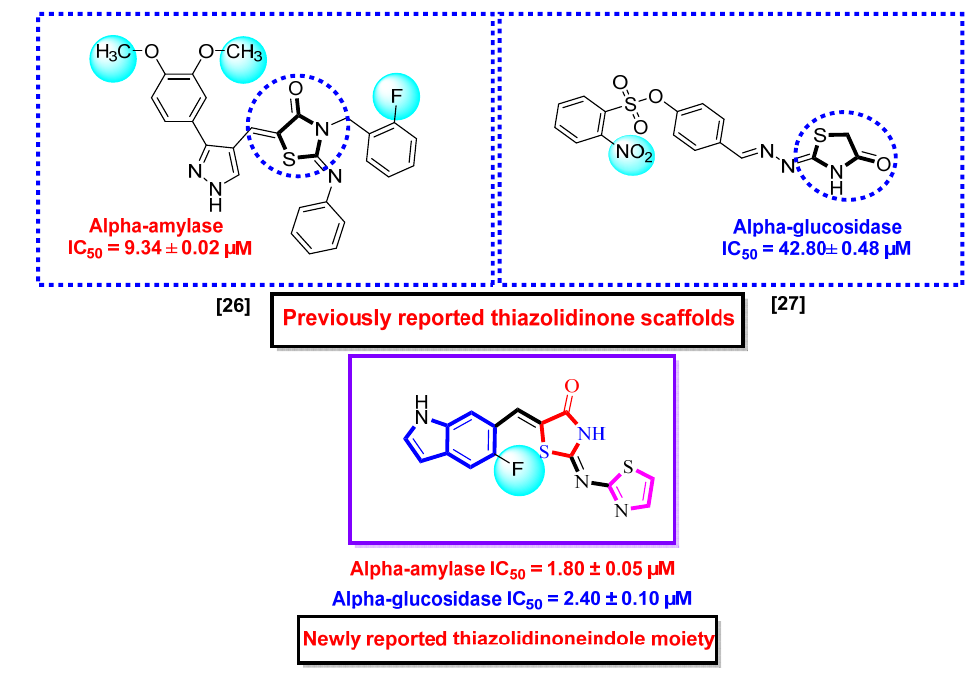
Figure 1. Rationale of the current